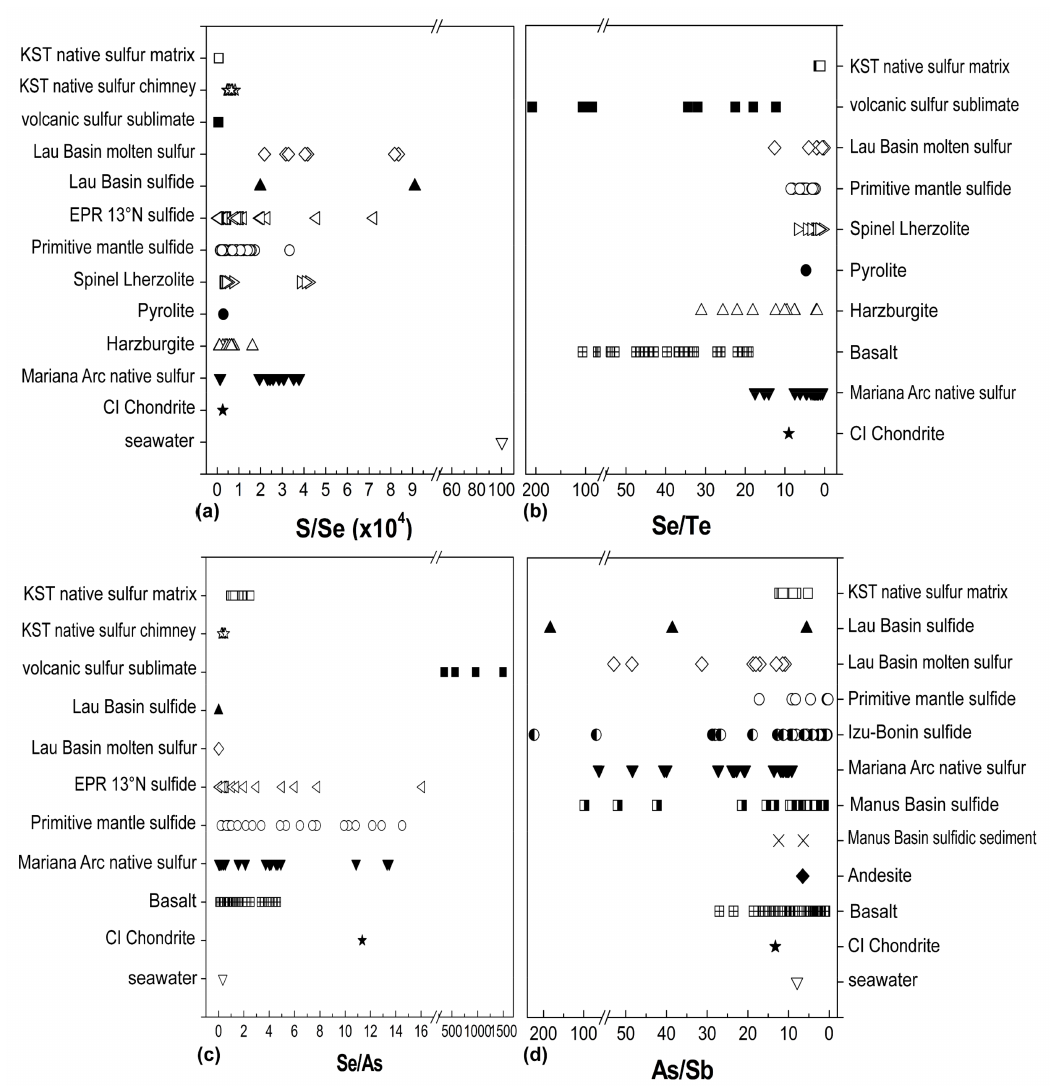
Figure 5. S / Se, Se / Te, Se / As and As / Sb ratios for Kueishantao (KST) native sulfur and other values taken from the literature. ( a ) Comparison for S / Se ratio; ( b ) Comparison for Se / Te ratio; ( c ) Comparison for Se / As ratio; ( d ) Comparison for As / Sb ratio. (cid:3) represents KST native sulfur matrix; represents KST native sulfur chimney; (cid:4) represents volcanic sulfur sublimate; sulfur; (cid:78) represents Lau Basin sulfide; represents EPR 13 ◦ N sulfide; sulfide; represents Spinel Lherzolite; (cid:8) represents Pyrolite; (cid:52) represents Harzburgite; (cid:72) represents Mariana Arc native sulfur; (cid:70) represents CI chondrite; (cid:53) represents seawater; represents Basalt; represents Izu-Bonin sulfides; represents Manus Basin sulfide; × represents Manus Basin sulfidic